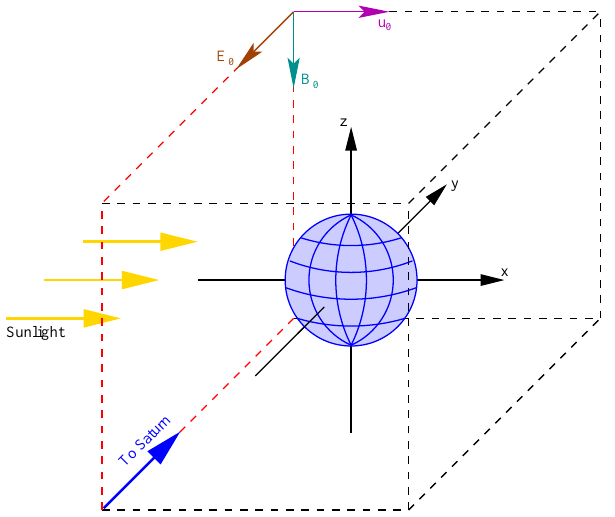
Fig. 1. Simulation geometry. The center of Titan coincides with the center of the cubic simulation domain, its extension being ± 7 . 5 R T in each spatial direction. The upstream plasma direction u 0 as well as the direction of the ionizing solar UV radiation are aligned with the positive x-axis. In the case of stationary upstream conditions, the undisturbed magnetic field B 0 is oriented antiparallel to the z-axis. This yields a convective electric field E 0 =− u 0 × B 0 that points in ( − y) direction, i.e. away from Saturn. All faces of the simulation box except for the left one (as denoted by the red dashed lines) have been treated as outflow boundaries. The left-hand face of the box has not simply been treated as an inflow boundary layer, but the electromagnetic fields in this face of the box have been var- ied in time during the simulations, the purpose being to mimic dis- torted magnetospheric upstream conditions in the vicinity of Titan. Details are discussed in Sect. 2 of the